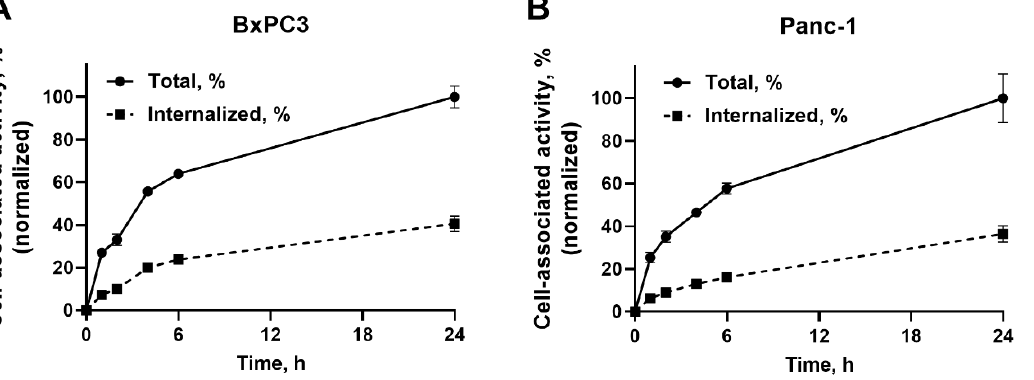
Figure 2. In vitro cellular processing and internalization of [ 99m Tc]Tc(CO) 3 -Ec1–LoPE in EpCAM- expressing BxPC3 and Panc-1 cells. Data were normalized to the value of total cell-associated activity at 24 h taken as 100%. The data are presented as the average ± SD (n = 3).